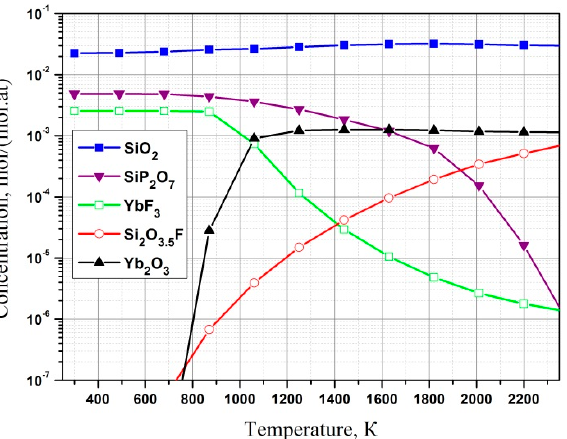
Figure 2. The temperature dependence of condensed phase compositions simulated for the initial gas mixture SiCl 4 + 1.26SiF 4 + 0.18POCl 3 + 0.1Yb(thd) 3 + 7.5O 2 at a pressure of 1